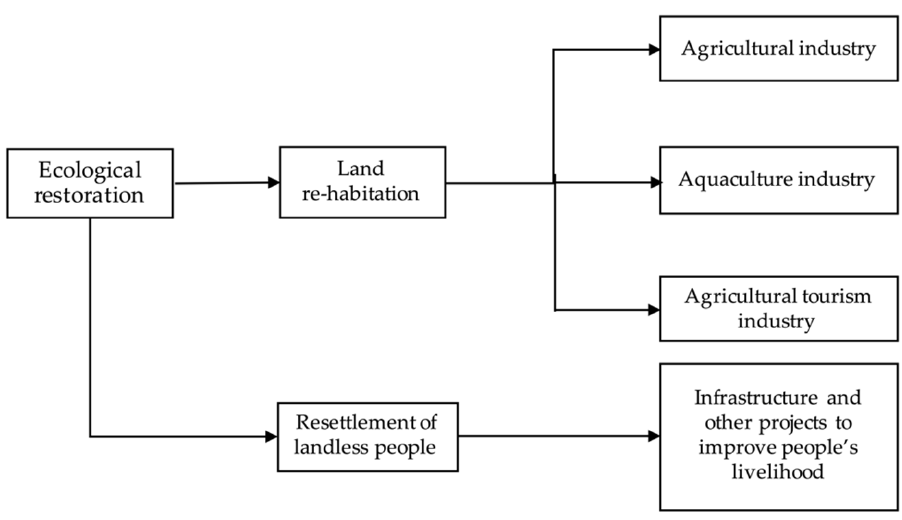
Figure 1. Steps on the control of coal mining subsidence area. Source: organized by the authors.